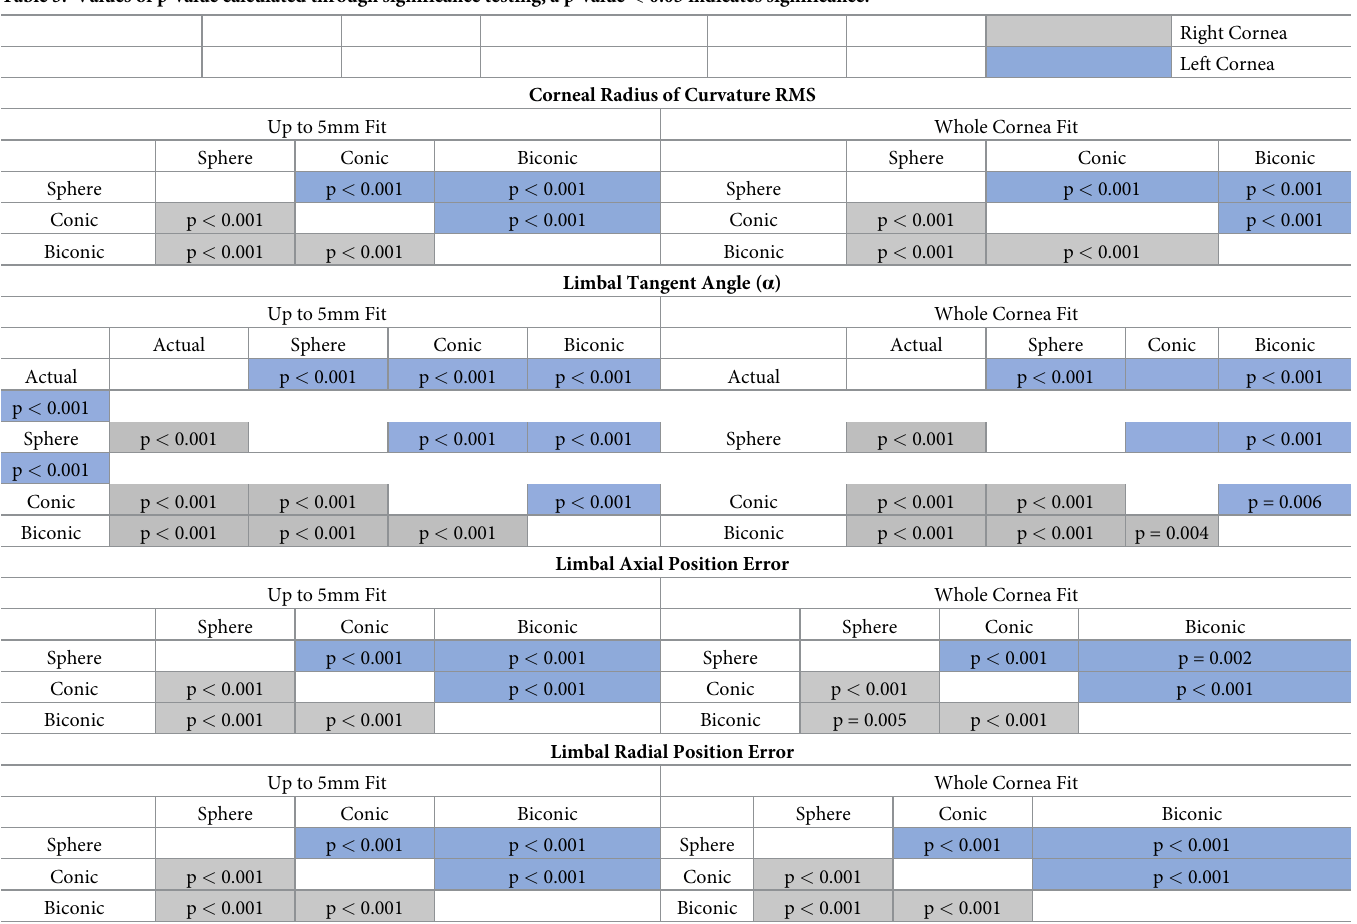
Table 3. Values of p-value calculated through significance testing, a p-value < 0.05 indicates